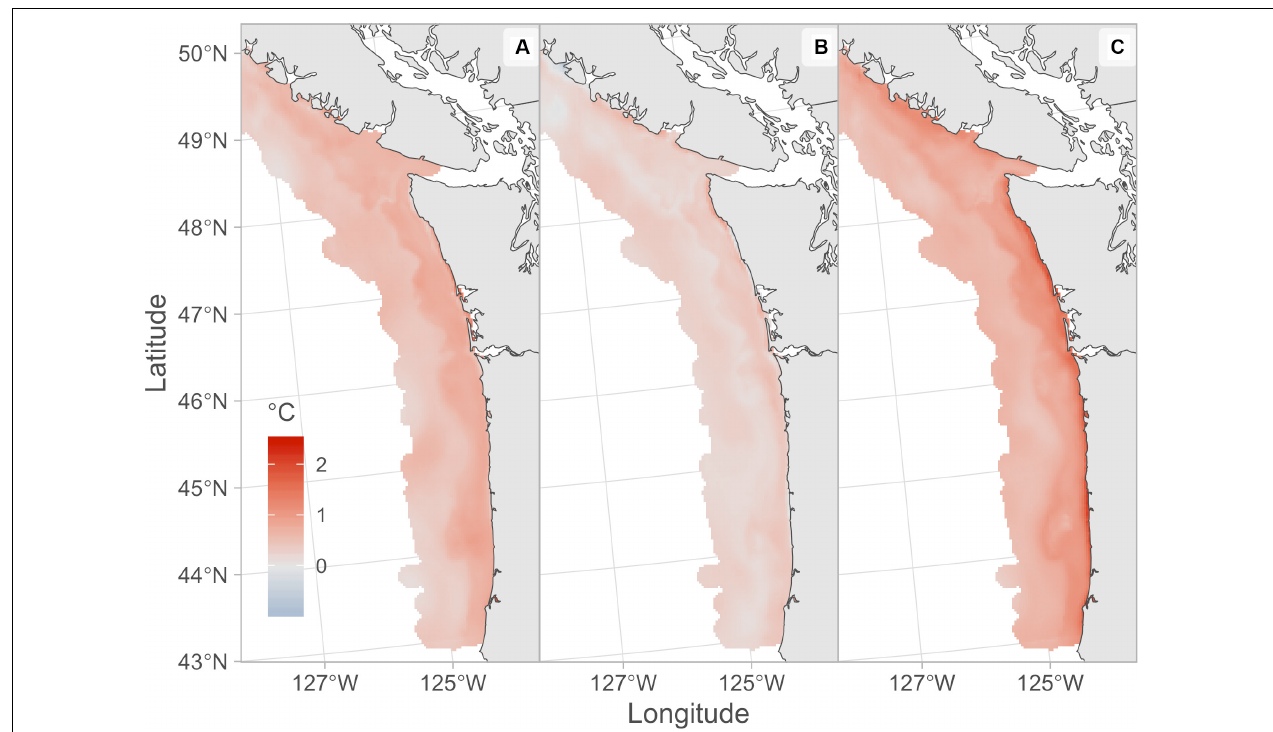
FIGURE 4 | January initialized August 2019 forecasts of temperature anomaly at 250 m depth from the J-SCOPE model. Each panel shows an alternative temperature forecast initialized on different days; (A) January 5, (B) January 15, (C) January